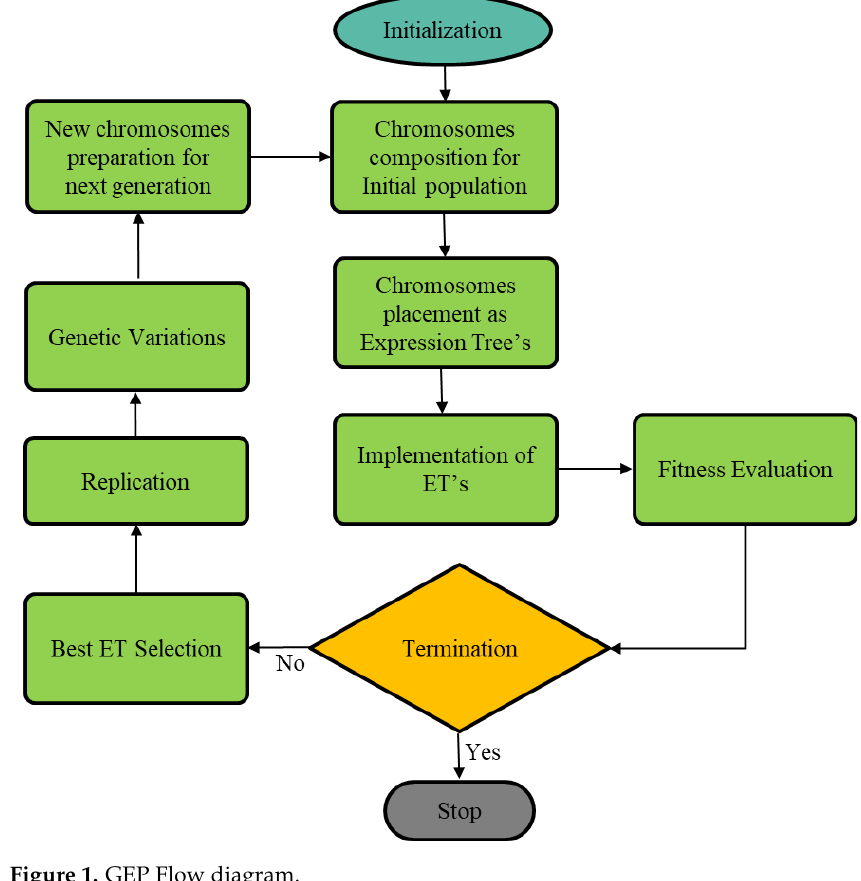
Figure 1. GEP Flow diagram.